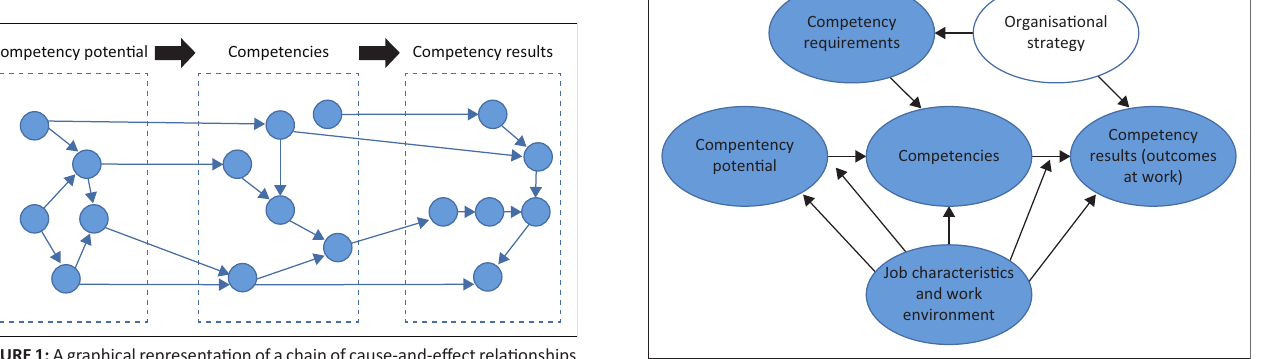
FIGURE 2: A five-domain representation of a competency